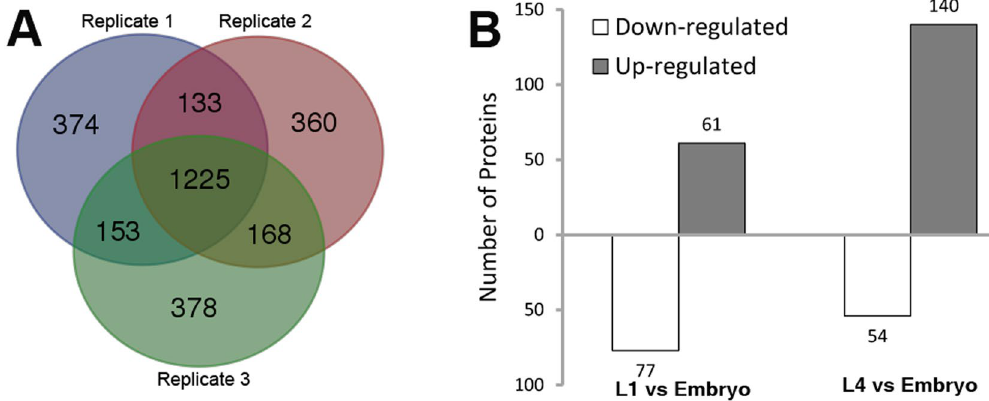
Figure 1. Comparison of proteomes identified by iTRAQ between three different replicates. ( A ) A Venn diagram showing the number of unique or shared proteins identified in three biological replicates. ( B ) Number of DEPs between embryonic and two larval stages (L1 and